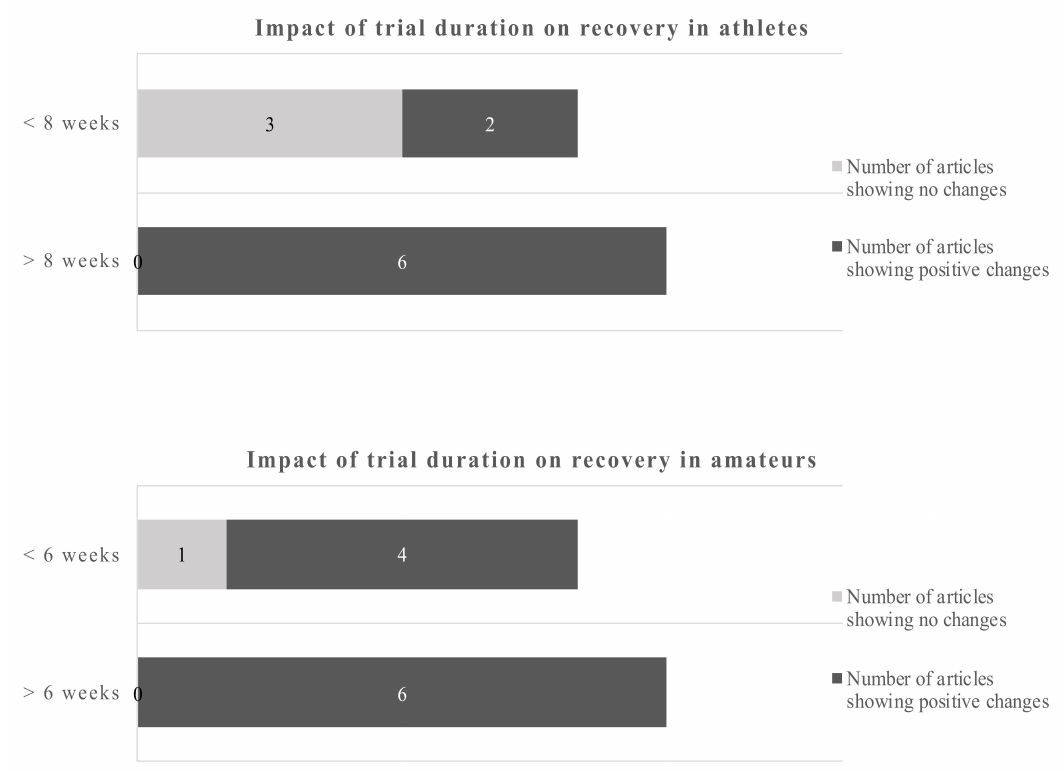
Figure 4. Impact of trial duration on recovery in athletes and amateurs by dichotomous